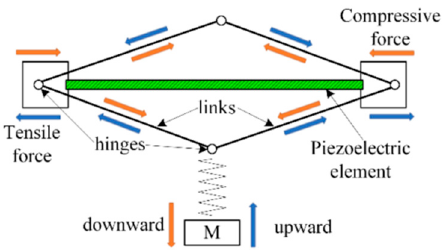
Figure 3. Truss-based compressive-mode piezoelectric energy harvester [29].